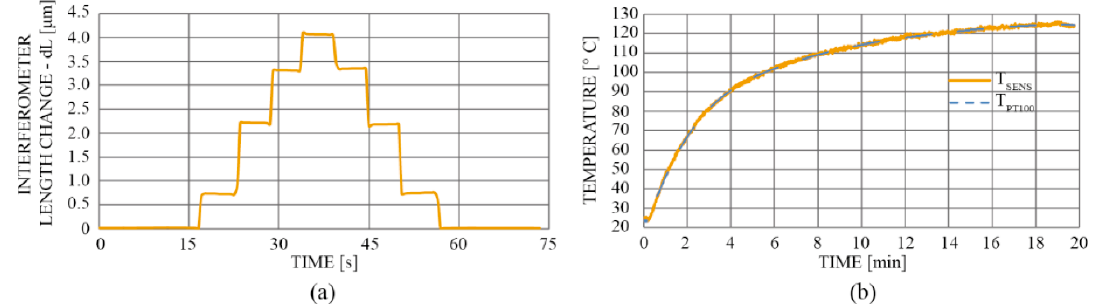
Figure 4. ( a ) Sensor elongation test for 4 μ m and ( b ) Temperature measurement and comparison with a reference temperature sensor (PT100).